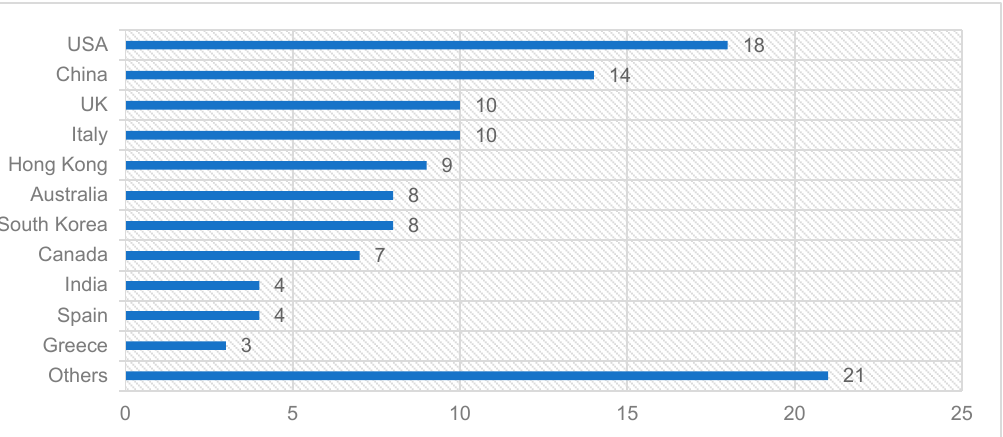
Figure 1. Distribution of reviewed papers by their country of implementation.